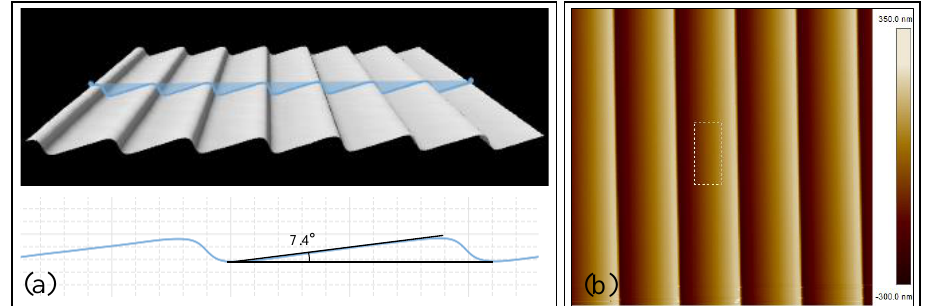
Figure 12. ( a ) Image of blazed grating profile; ( b ) AFM image of the blazed grating.